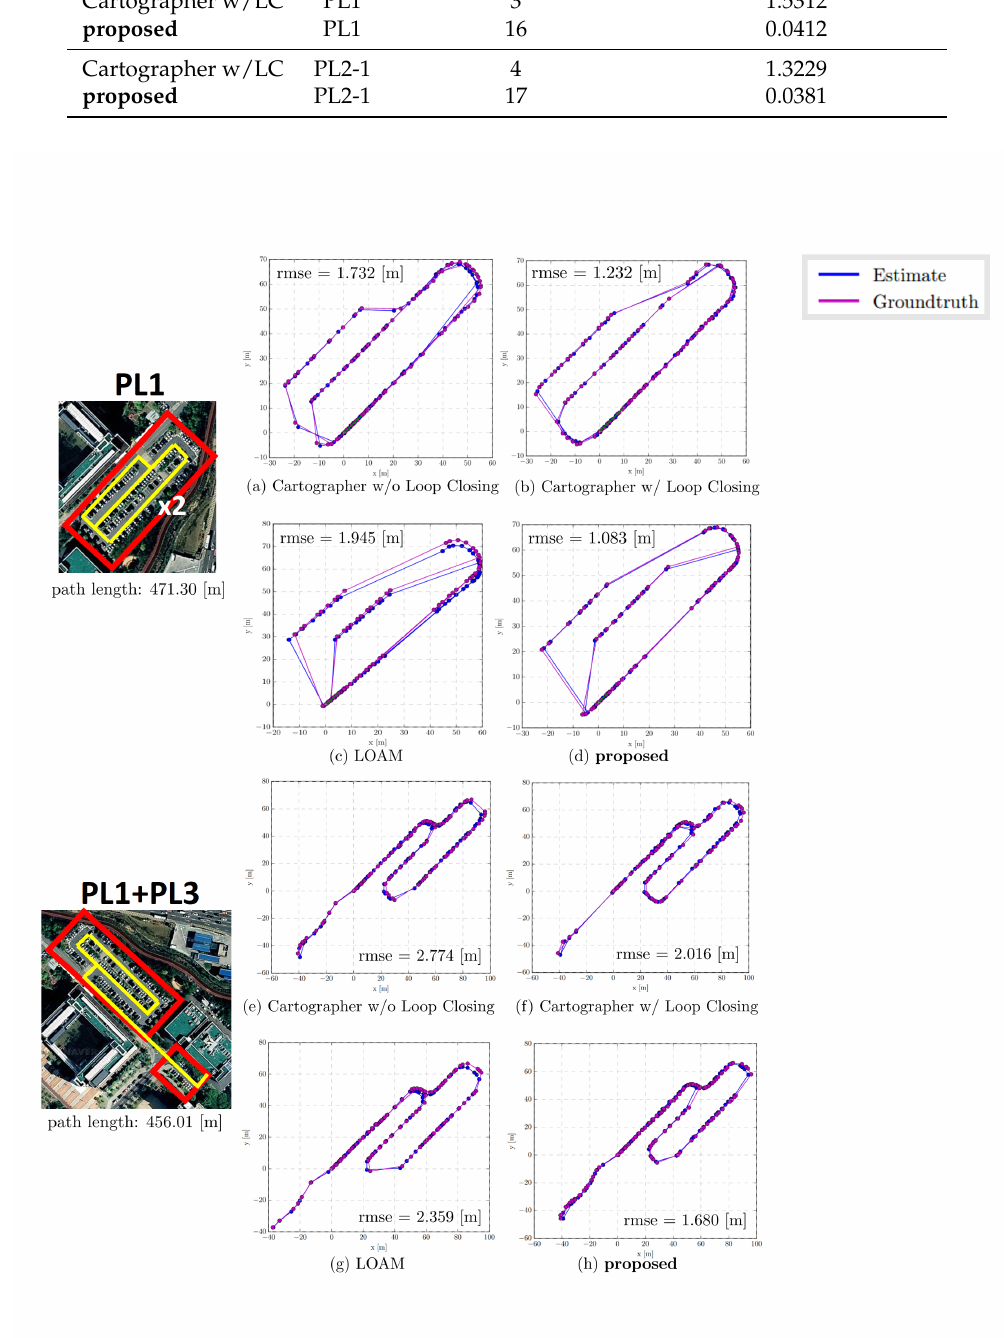
Figure 13. Illustration of SLAM trajectory evaluation. Experiments were conducted in two outdoor parking lots PL1 and PL1+PL3. The evaluation was performed by comparing between the ground truth (GPS) and estimated trajectory. The blue line indicates the estimated trajectory generated by the SLAM algorithm, and the purple line indicates the ground truth (GPS). The blue and purple dots indicate the location where timestamp matching occurred. In the case of ( c , d ), the timestamp matching occurs sparsely, and the path appears relatively